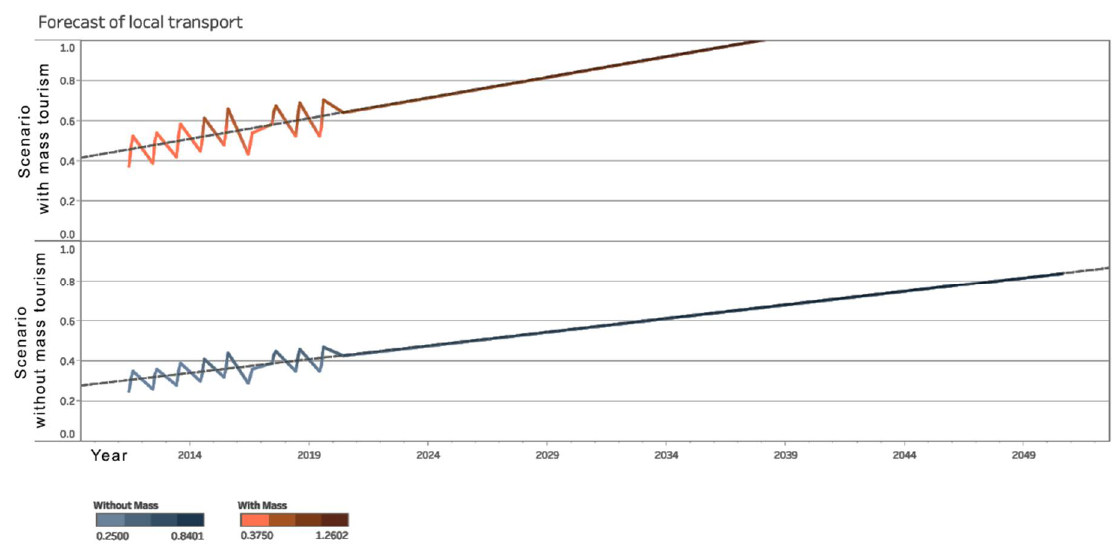
Figure 6. Forecast of local transport activity by 2050.